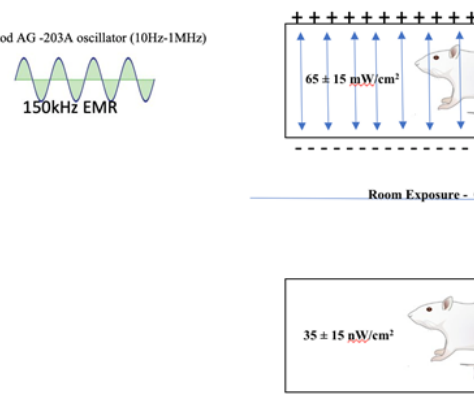
Figure 1. Schematic diagram of experiment setup and EMR generation system.